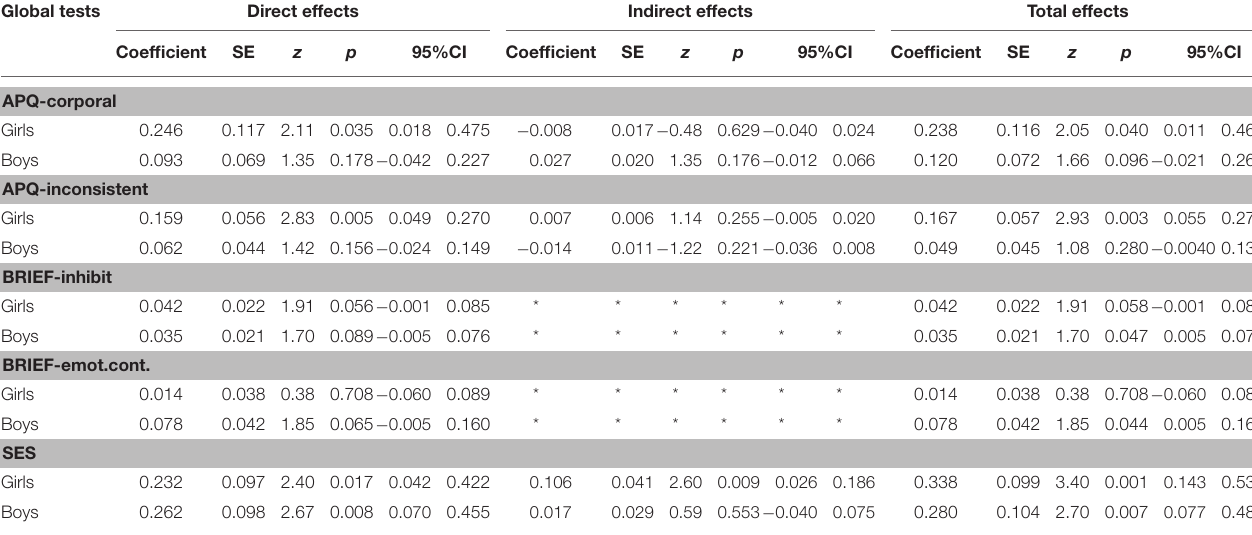
TABLE 4 | Sobel mediation tests for the global SEM: direct and indirect effects of APQ and BRIEF on the dependent variable ODD level. Global